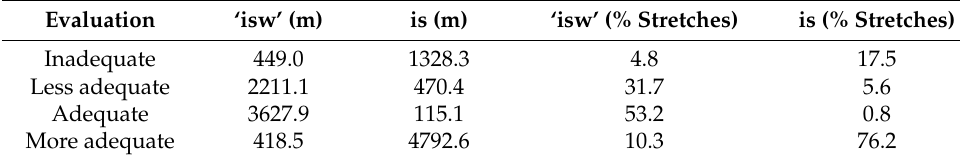
Table 16. Comparison between ‘isw’ and